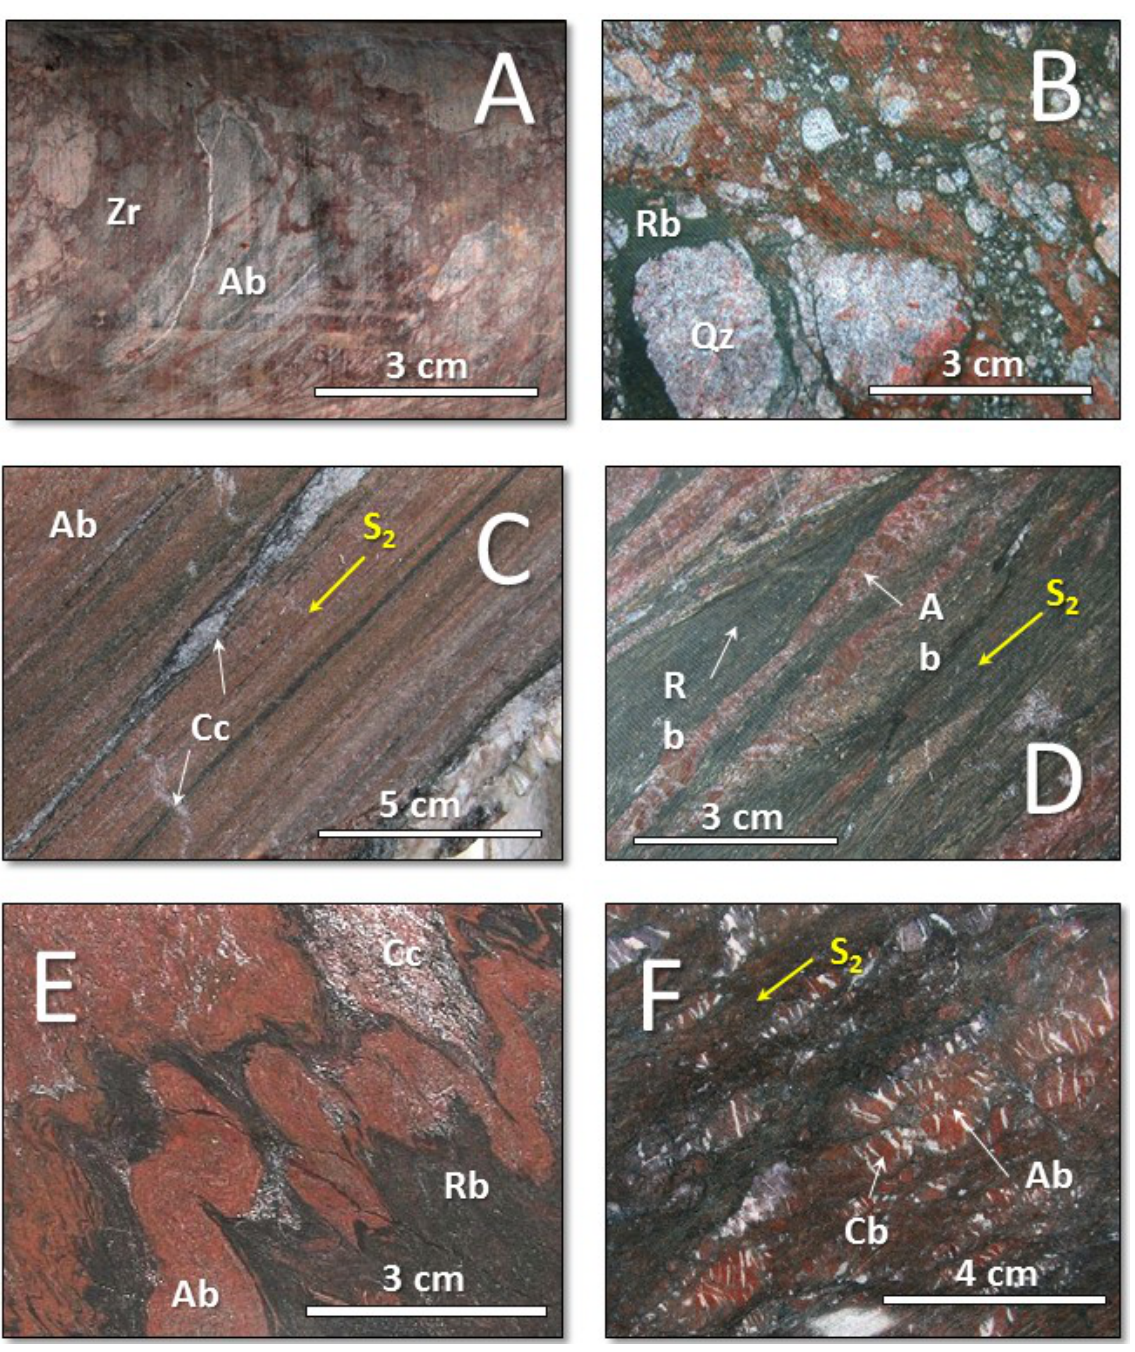
Figure 3. Examples of rock types from the Mount Isa uranium region: ( A ) Valhalla VRD185 232.1 m. Brecciated albitite (Ab) with matrix of dark red hydrothermal zircon (Zr). ( B ) Skal SD084 56.4 m. Breccia of rounded early quartz vein fragments in dark green riebeckite-rich matrix. ( C ) Typical laminated ore, Bikini BPDD024 169 m. Ab, Albitite. Cc, late calcite vein emplaced parallel to and transgressive to S Boudinaged lithons of albitite (Ab) enveloped by spaced S riebeckite (Rb). Cc, calcite-rich area. ( E ) Mirrioola MIDDH012 109 m. Folded albitite (Ab) with partially transposed limbs. Riebeckite-rich matrix (Rb). ( F ) Queen’s Gift QGDC008 81.5 m. Similar to ( E ), showing greater abundance of milky white carbonate (Cb)